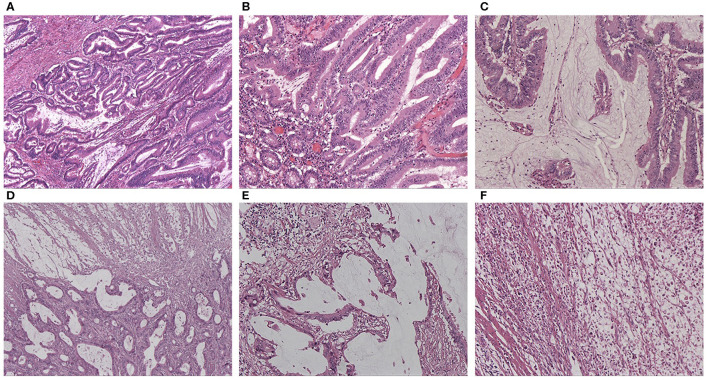
(A) HE staining of AWMC showing both classical adenocarcinoma component and mucinous component (HEx40). (B) HE staining of AWMC showing classical adenocarcinoma component (HEx100). (C) HE staining of AWMC showing mucinous component (HEx100). (D) HE staining of AWMC with signet ring cell component (HEx40). (E) HE staining of AWMC with signet ring cell component showing mucin pool (HEx100). (F) HE staining showing scattered signet ring cells in the same case with D and E (HEx100).